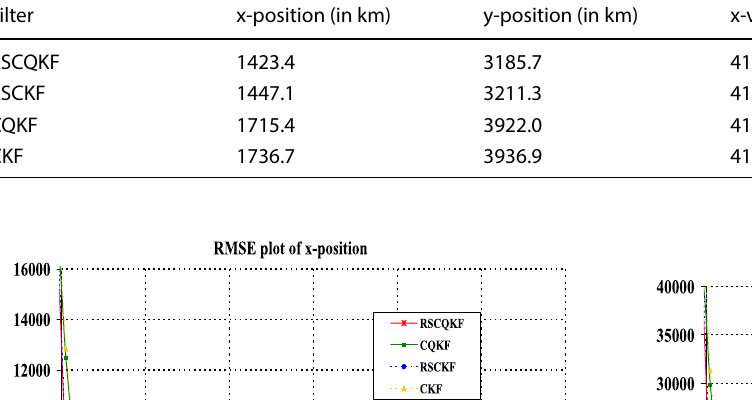
Table 1 Average root mean square error of RSCQKF, RSCKF, CQKF and CKF Filter